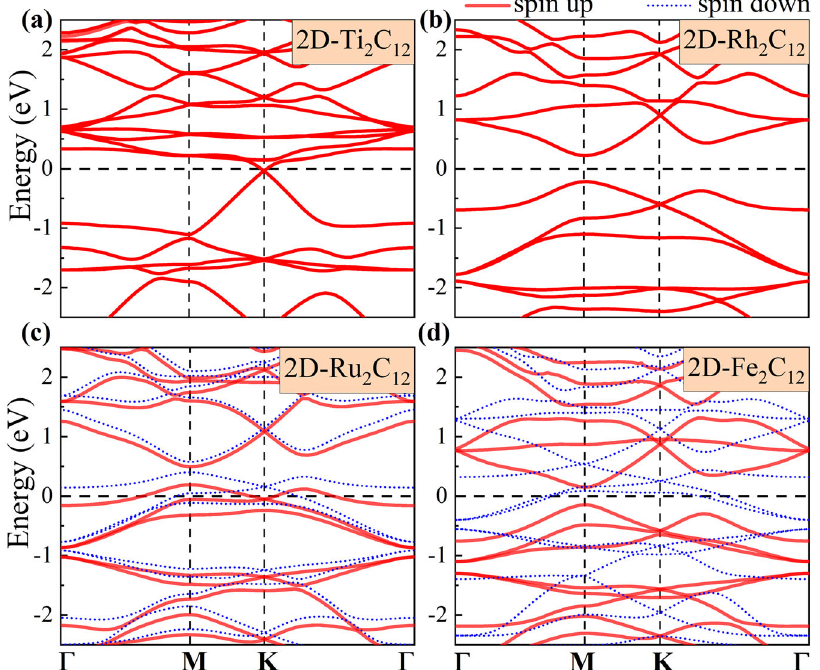
Fig. 2 Electronic band structures of 2D-M 2 C 12 . The band structures of a 2D-Ti 2 C 12 , a nonmagnetic metal; b 2D-Rh 2 C 12 , a nonmagnetic semiconductor with a bandgap of 0.45 eV at M point; c the magnetic and metallic 2D-Ru 2 C 12 ; and lastly, d the half-metallic 2D-Fe 2 C 12 with a semiconducting spin-up channel of quasi bandgap 0.30 eV at M point. c , d spin-up (-down) bands are in red